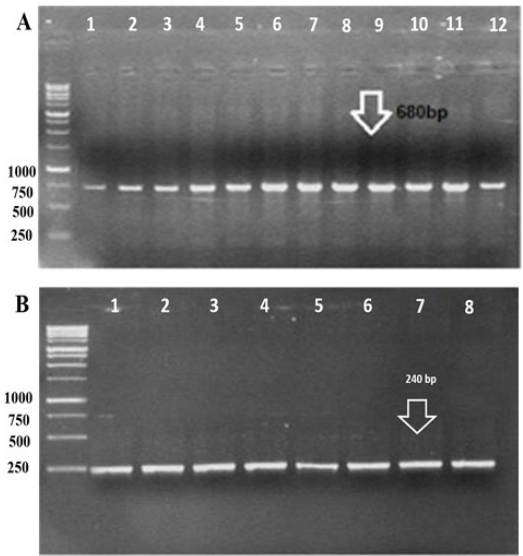
Fig. 2. Agarose gel electrophoresis results: (A) Agarose gel electrophoresis for dsRed gene fragment; Lane 1:1kb size marker, lanes 2-8 dsRed fragments amplified in cream zebrafish with red parents, 9-12 dsRed fragments amplified in red zebrafish.13 dsRed fragments amplified by vector containing dsRed gene. Size of fragment is approximately 680bp. electrophoresis for 16 S rDNA gene fragment for zebra Danio detection; Lane 1:1kb size marker, lanes 2-9 16S rDNA amplified in red and cream zebrafish. Size of fragment is approximately